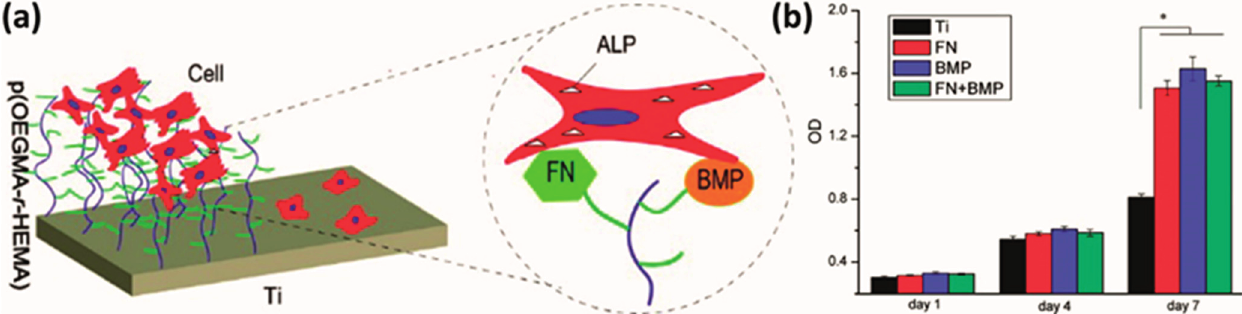
Figure 15. ( a ) Schematic depiction of P(OEGMA-HEMA) brushes on Ti functionalized directly with fibronection (FN), BMP or both FN and BMP; and ( b ) The pullout force of the modified implant material 1, 4 and 7 days after implantation. * denotes significant differences between marked groups using p < 0.05 with ANOVA (Reproduced with permission from Reference [190] Copyright 2011, American Chemical